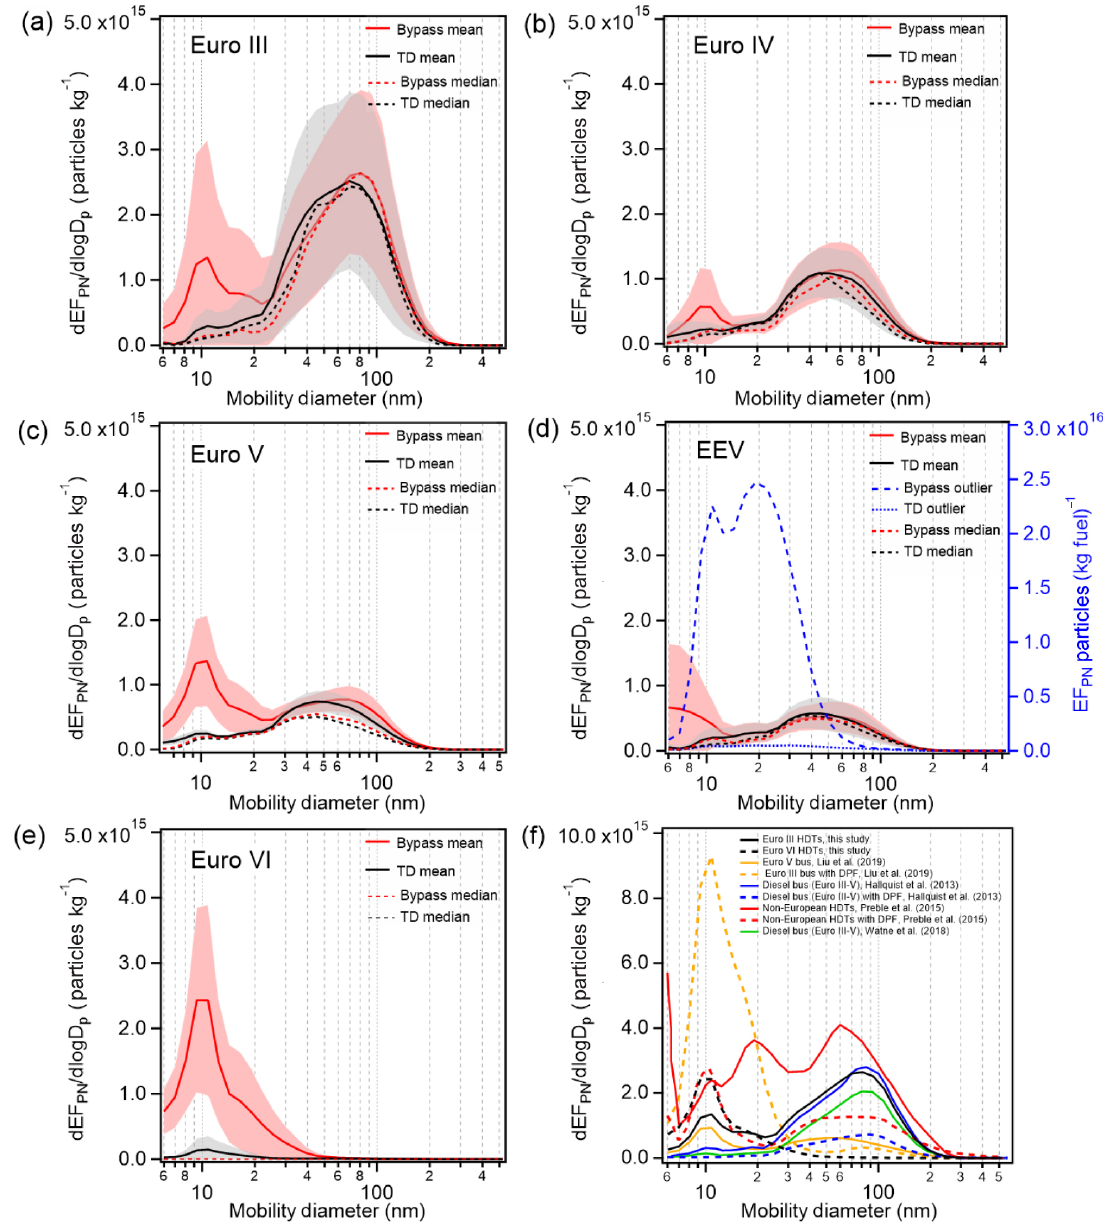
Figure 4. (a–e) Mean and median size-resolved EF PN and EF non-volatilePN of different Euro class HDTs and (f) comparisons of mean size- resolved EF PN of HDVs in this study and previous studies. Shaded regions in (a–e) represent the statistical 95% confidence interval. One HDT with extremely different EF in (d) was excluded from the analysis and shown in